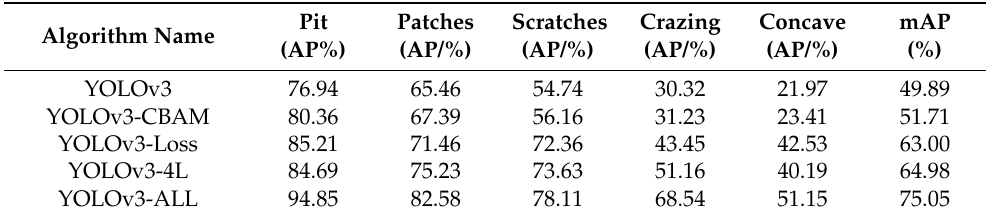
Table 6. Experimental performance evaluation.